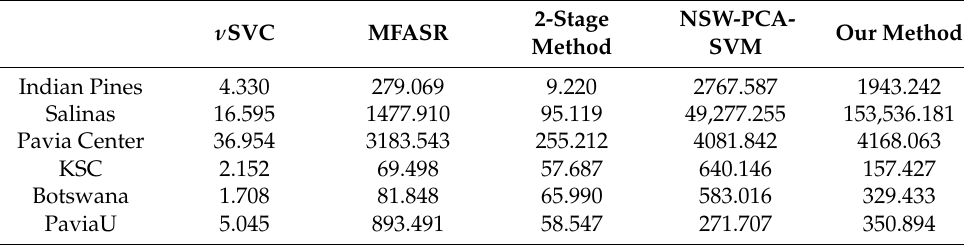
Table 7. Comparison of computation times (in seconds) for 10 training